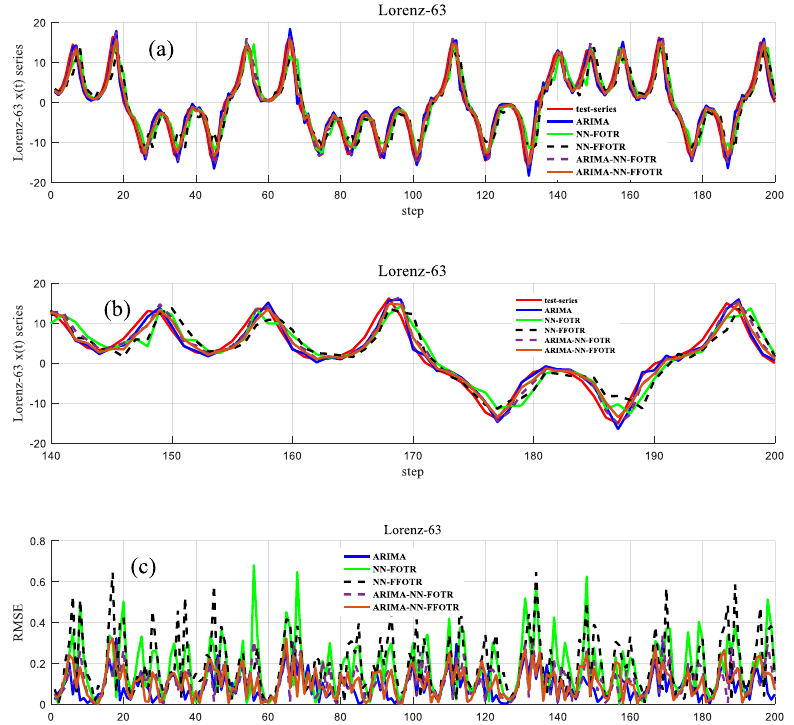
Figure 9. Results of the predictions for the Lorenz-63 series. ( a ) Overall, ( b ) local enlargement, ( c ) RMSEs for the Lorenz-63 series.